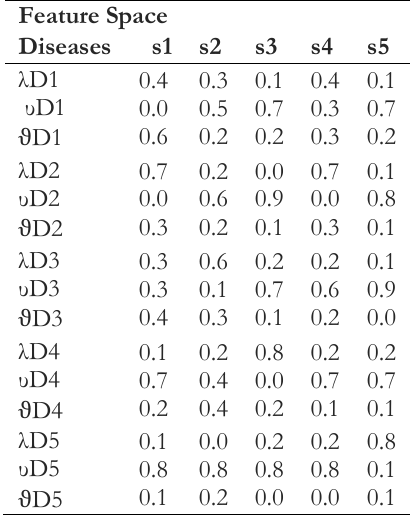
Table 1. Intuitionistic fuzzy medical representations I.